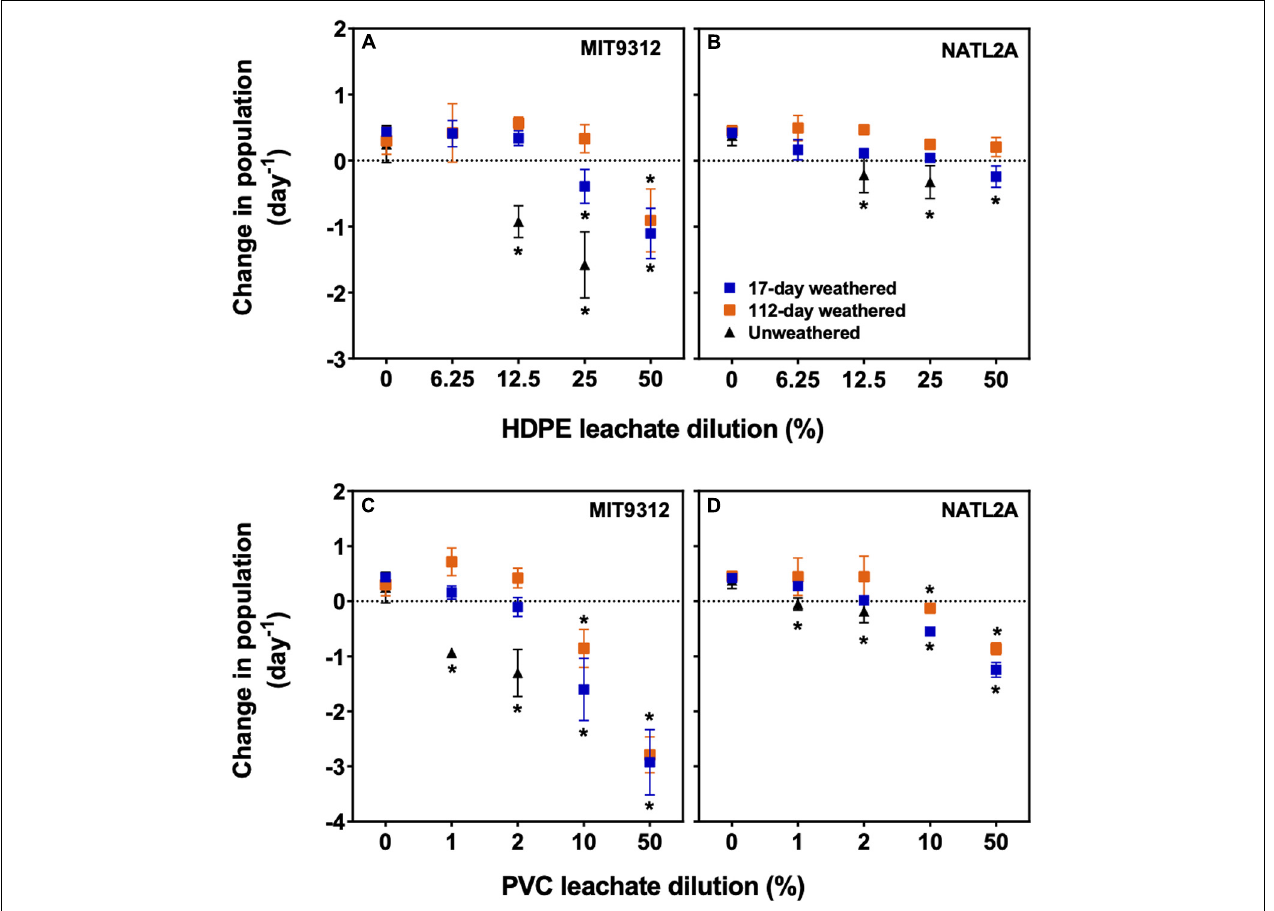
FIGURE 1 | Rate of population change (A–D) of Prochlorococcus MIT9312 and NATL2A in AMP1 media in the presence of different dilutions of leachates from HDPE and PVC materials subjected to two weathering treatments (17- and 112-days in estuarine sea water). Experiments were conducted over 48 h using biological replicates ( n = 4; except unweathered treatment, n = 3) for each condition shown as mean values of all replicate cultures with error bars representing the standard deviation. Asterisks (*) indicate that the rate was significantly ( p < 0.01) different for a specific leachate concentration relative to the no leachate control (0% leachate dilution). Symbols shown in panel (B) indicate the weathering treatment for all